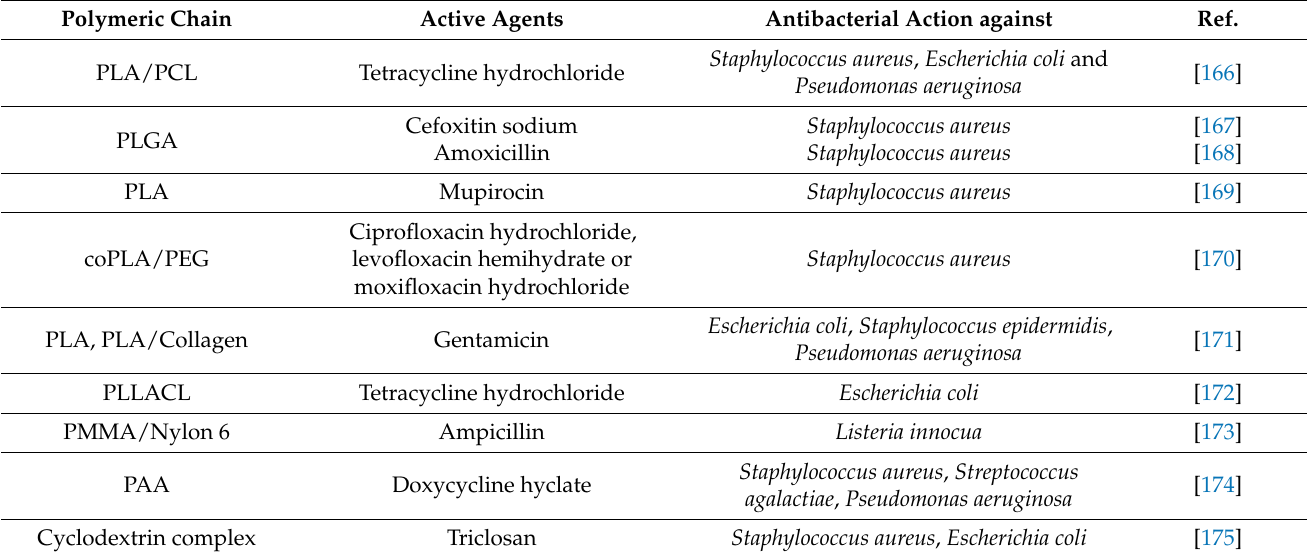
Table 4. A literature review of various antibacterial wound dressings prepared using the ES